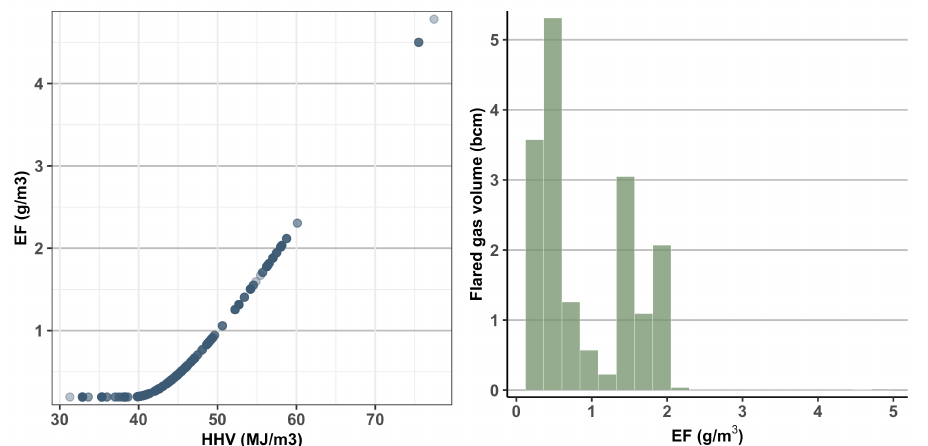
Figure 3. BC emission factors estimated for all flares based on Böttcher et al. [18]. Left : relationship between HHV (MJ/m 3 ) and emissions factor (EF) (g/m 3 ), where darkness indicates number of points overlapped. Right : a histogram of black carbon EFs, weighted by volume of gas